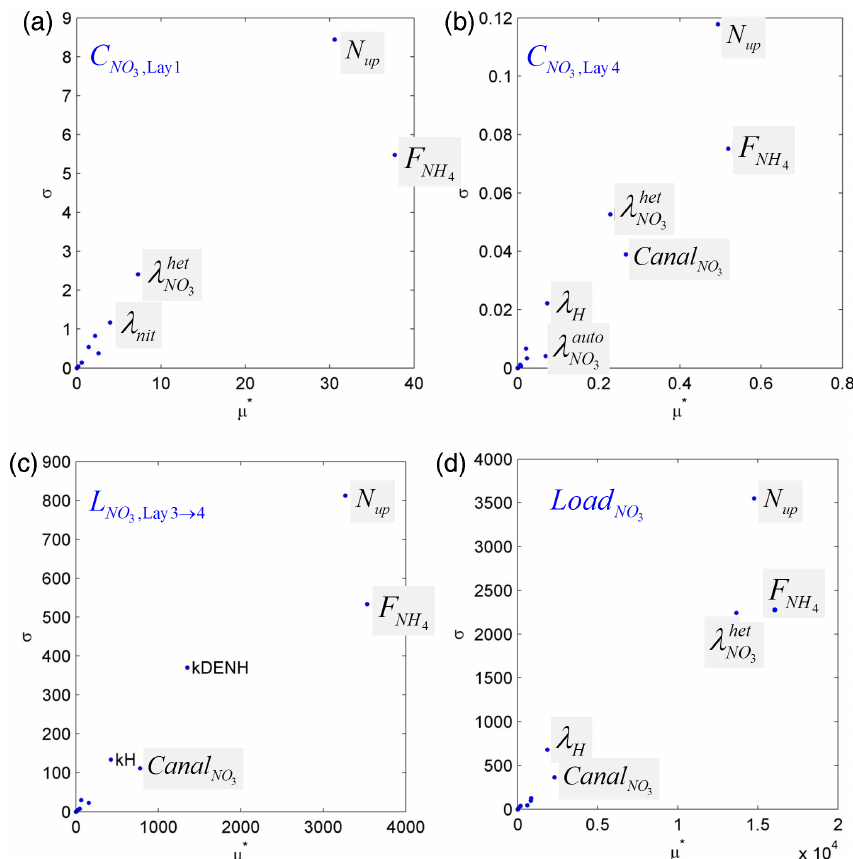
in layer 1 of the model 3